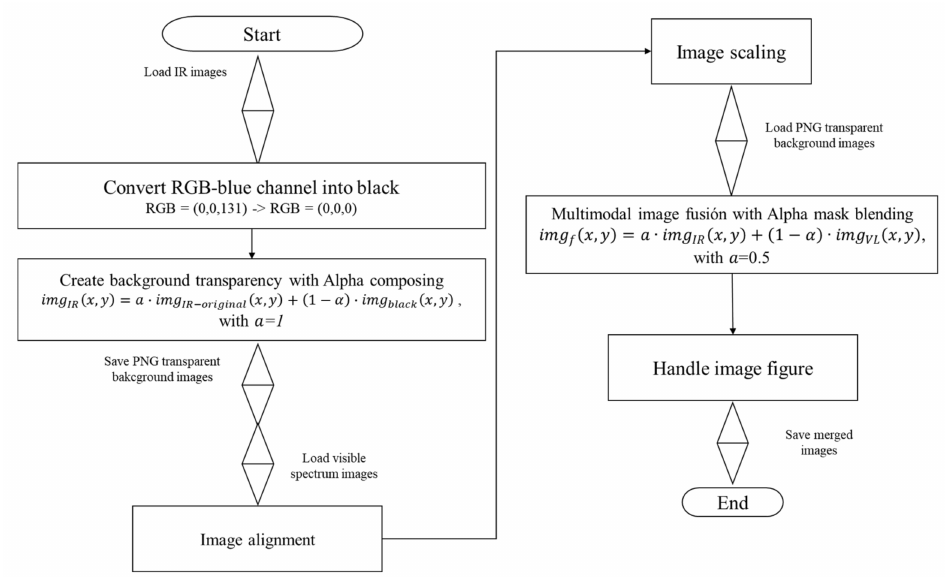
Figure 7. Flowchart of the multimodal co-registration. For each IR image, the blue background was transformed into black to apply the alpha mask transformation. The visible-light images were co-registered with the IR images by alignment, scaling, and